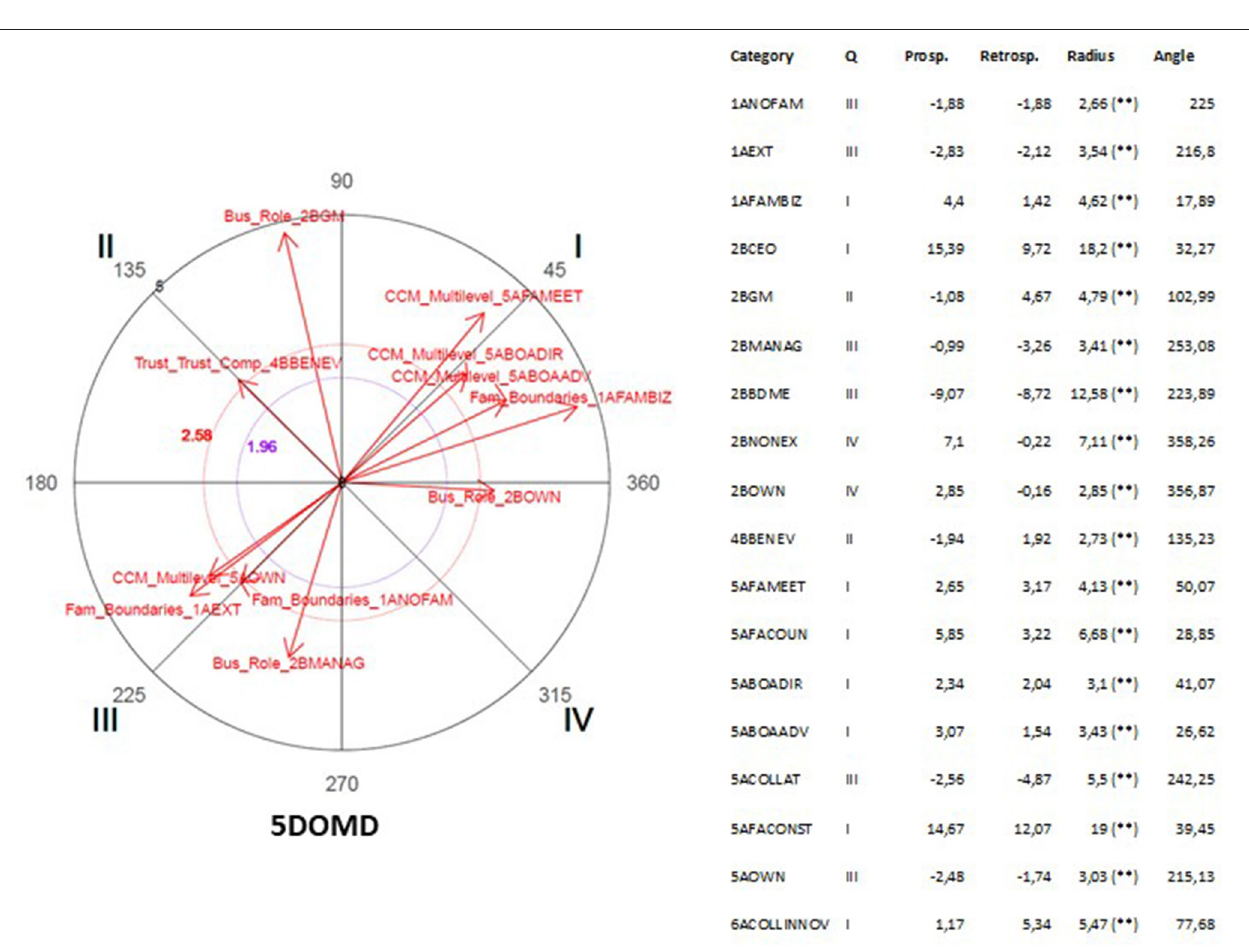
FIGURE 7 | Example C of vectorial map of the statistically significant relationships. The graph exhibits the vectorial map of the statistically significant relationships for the subdimension of open-mindedness (5DOMD) considering the following as conditional behaviors: family boundaries (1A), business roles (2B), trust (4A), trust components (4B), lack of trust (4C), multilevel system (5A), and innovativeness (6A). The table contains the results of the polar coordinate analysis. The significance level was fixed at ** p <